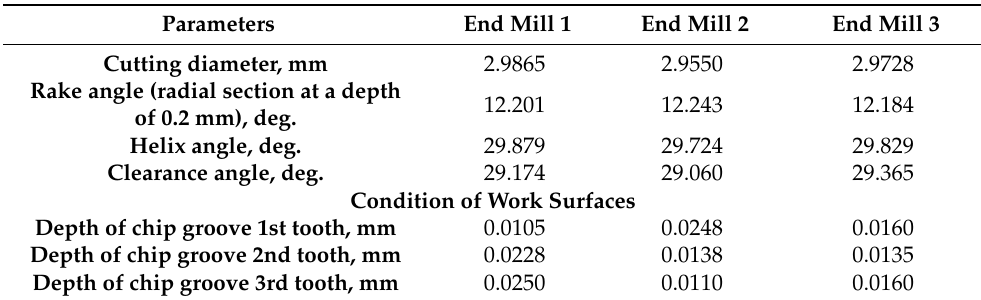
Table 1. Results of primary measurements for the working geometry of three samples. Parameters